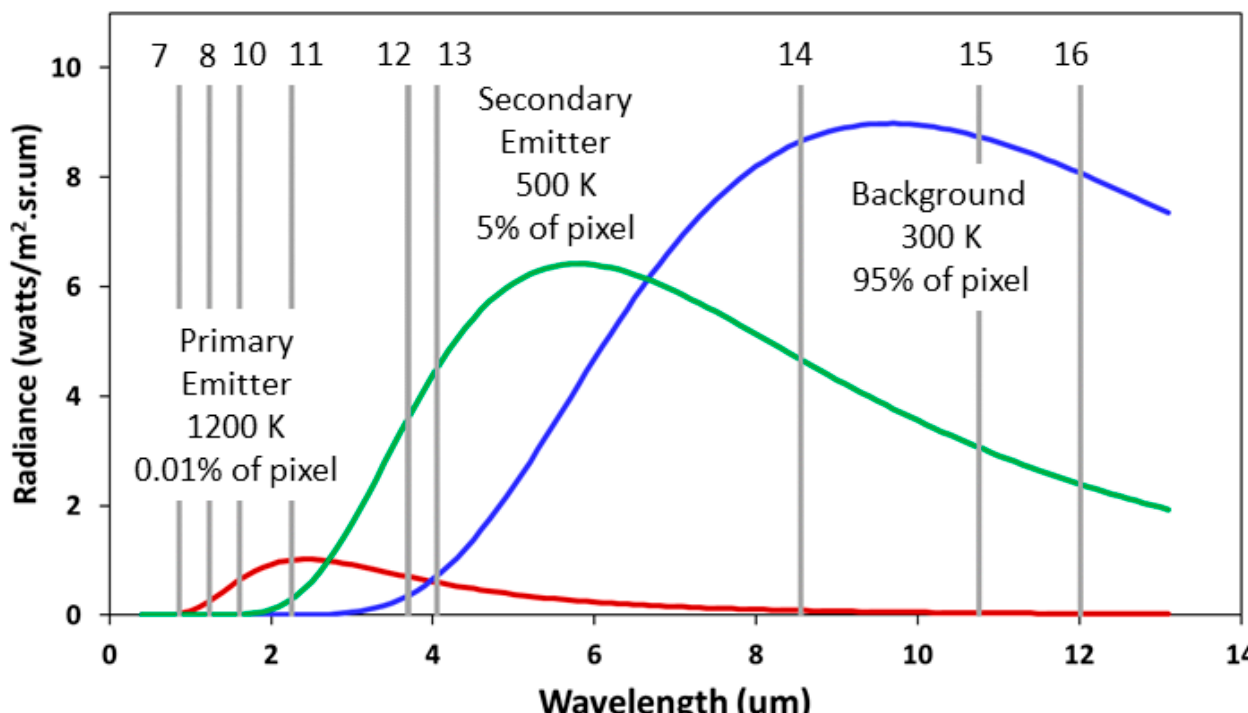
Figure 3. Planck curves representing a primary emitter at 1200 K, secondary emitter at 500 K and background at 300 K. Vertical lines are the central wavelengths for the spectral bands used in VIIRS nightfire. Note that the Planck curves are offset—an expression of Wein’s Displacement Law.